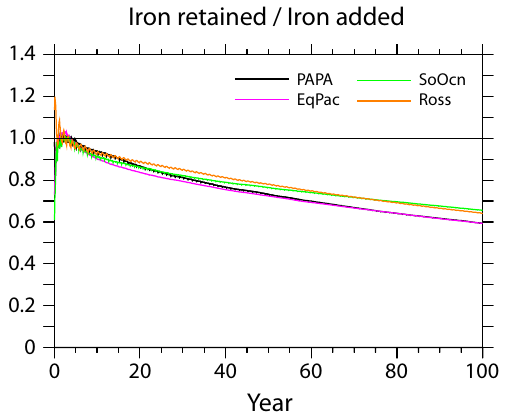
Fig. 12. The ratio of iron retained in the ocean with respect to the iron added in the 1200x scenario. Despite the continuous addition of iron in this model, the scavenging of iron out of the ocean is such that only ∼ 60% of the iron is present at the end of the simulation.